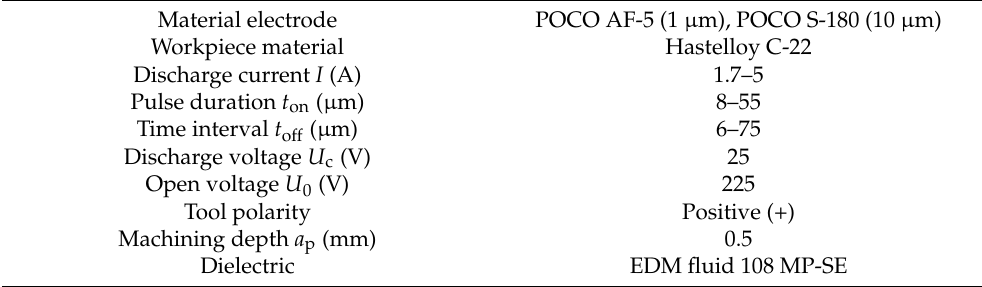
Table 3. Machining conditions.